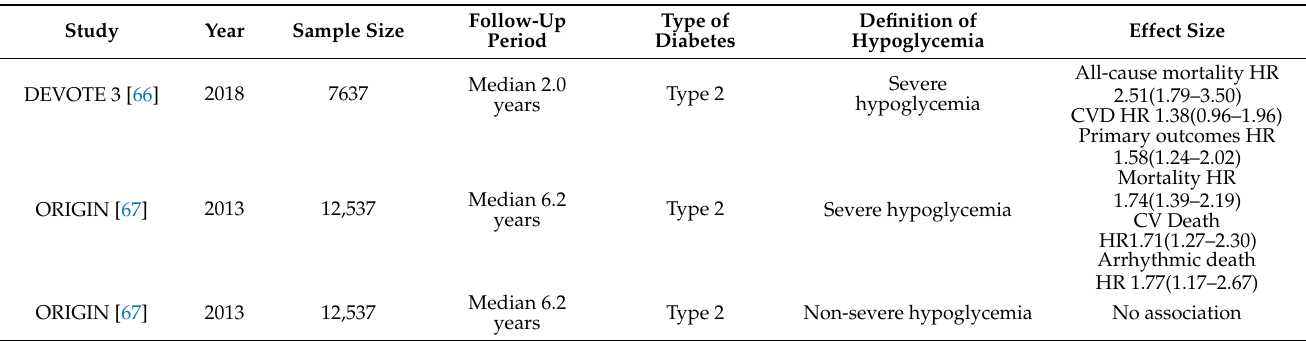
Table 2. Clinical studies related to the association of hypoglycemia with CV outcomes in type 2 diabetic